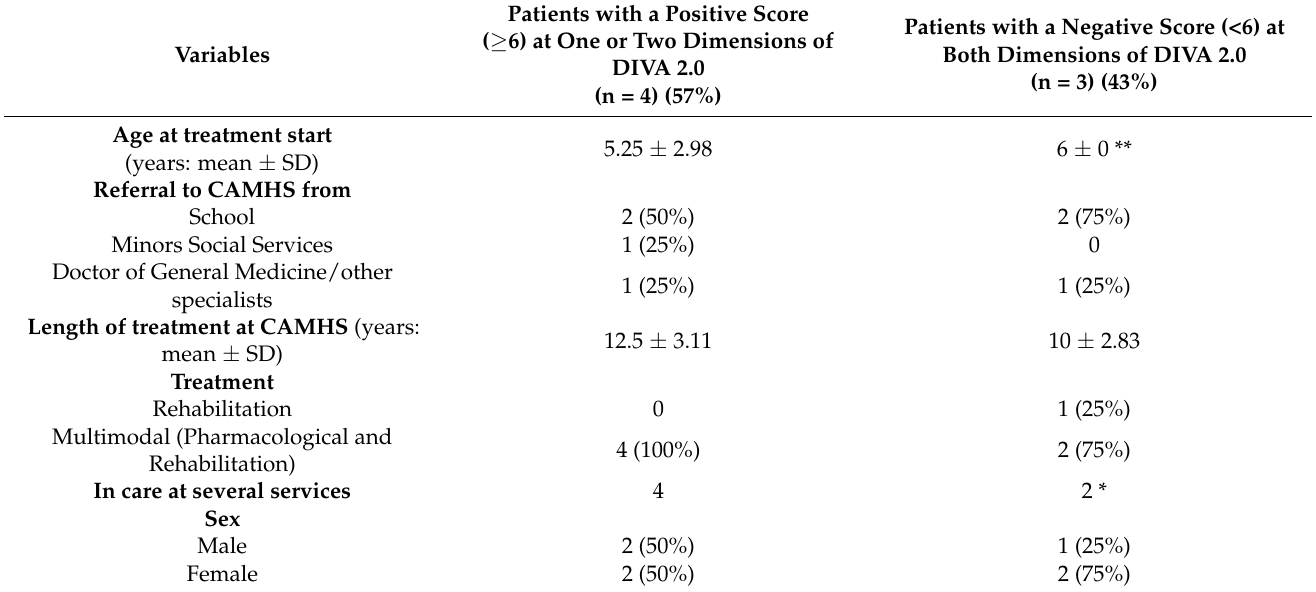
Both Dimensions of DIVA